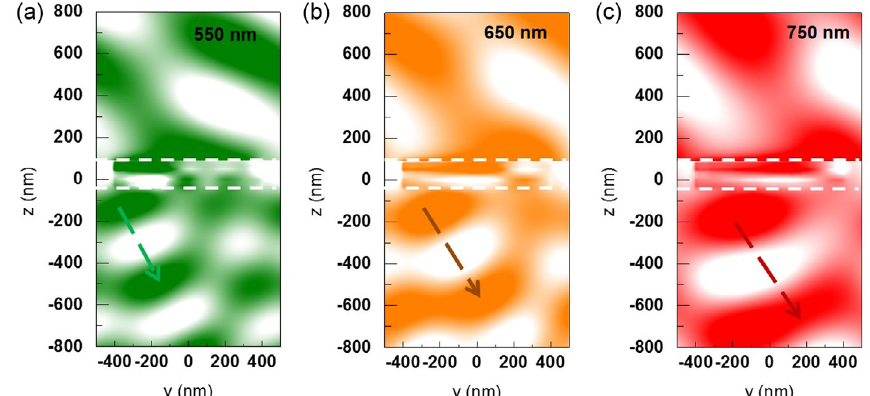
Figure 4. Calculated near-field profiles and wavefront shapes of the transmitted waves below the triple-layered (Ag-SiO 2 -Ag) resonator arrays at 550 nm, 650 nm and 750 nm, respectively. The directions of the arrows denote the propagation direction of transmitted waves and the lengths of the arrows indicate the wavelength size of each frequency component of